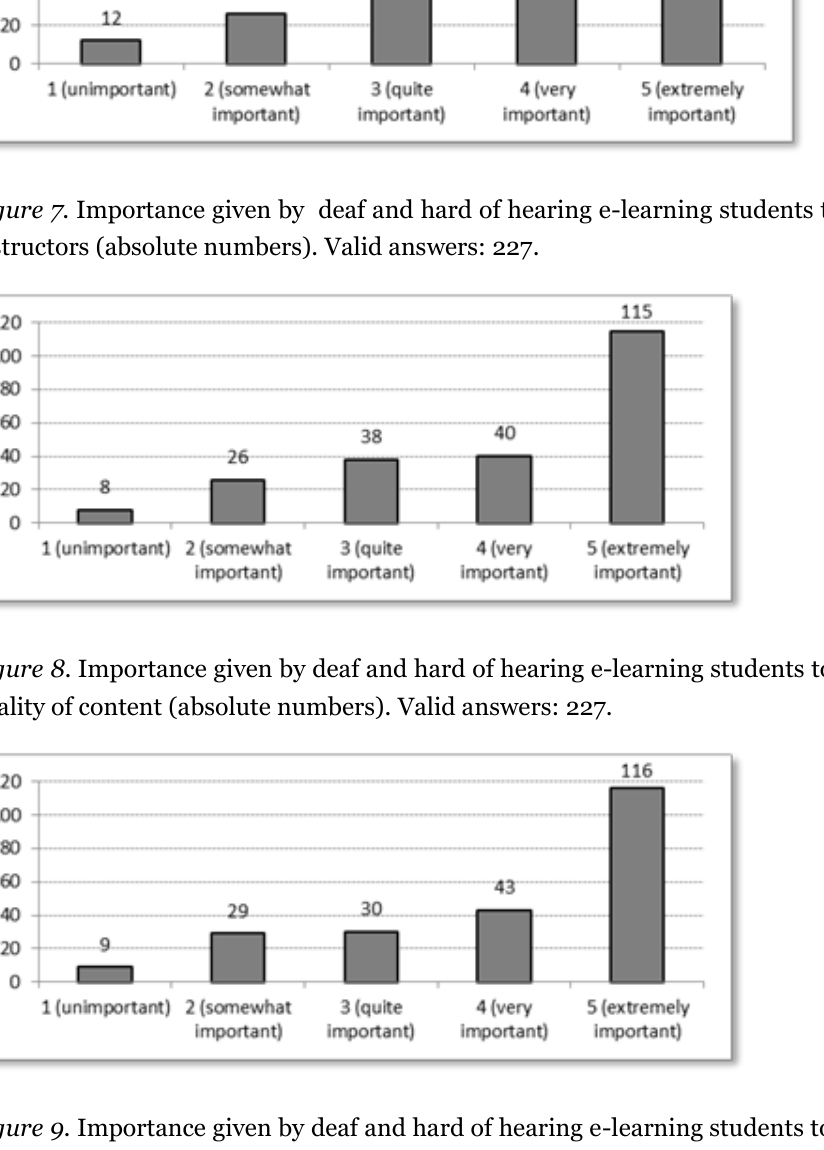
Figure 9. Importance given by deaf and hard of hearing e-learning students to the technological quality of the platform (absolute numbers). Valid answers: